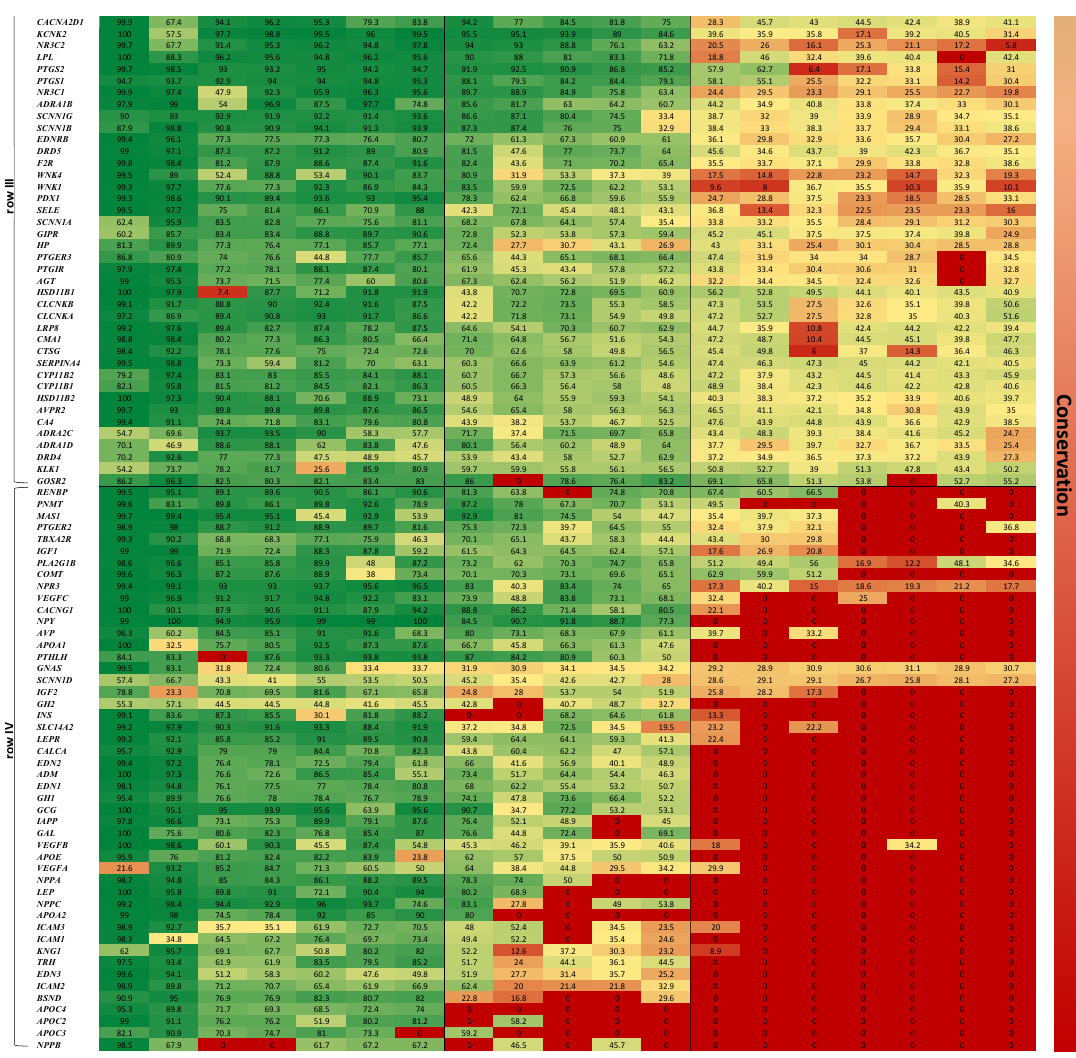
Figure 1. Heatmap displays the hierarchical clustering of similarity percentage scores between human BP genes (vertical axis) and their orthologs in 19 organisms (horizontal axis). Green color denotes the more conserved genes across the 19 organisms, aligned at the top of the map (see conservation scale arrow to the right of map). A phylogenetic tree describing the developmental order is placed above the map.